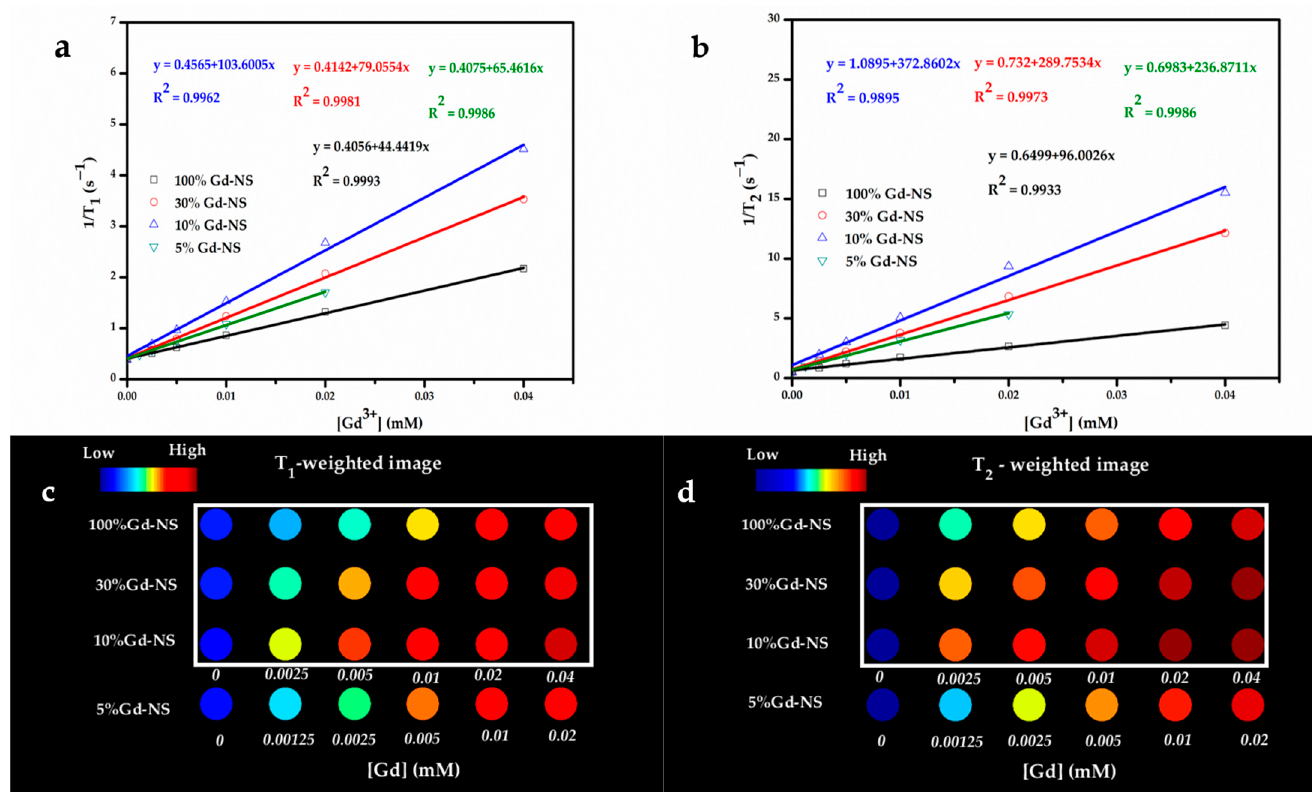
Figure 3. T 1 relaxivity plot ( a ), T 2 relaxivity plot ( b ), T 1 -weighted phantom images ( c ), and T 2 -weighted phantom images ( d ) of the samples as a function of the Gd 3+ concentration (at 3T). The values of the color-coded scale with no unit in ( b ) refer to the gray level of each pixel of images, ranging from 0 (black) to 255 (white); these could be regarded as the signal intensity, and a high value corresponds to a high signal intensity and a bright image.